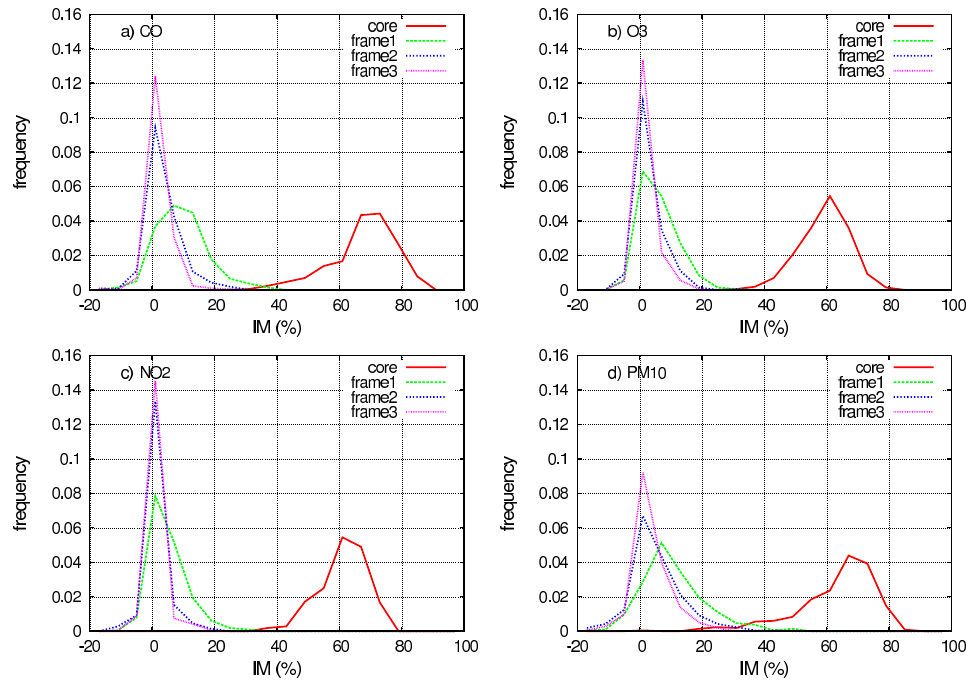
Fig. 5. Frequency distribution of the Index of Improvement for each species and for each frame. The dataset shown here includes the entire year of data. Fig. 4. Taylor diagrams of LR run vs. HR run (black symbols) and of LRn run and HR run (red symbols) for all species and for the 4 different regions. Panel a shows the results in the core, panel b in frame 1, panel c in frame 2 and panel d in frame 3.